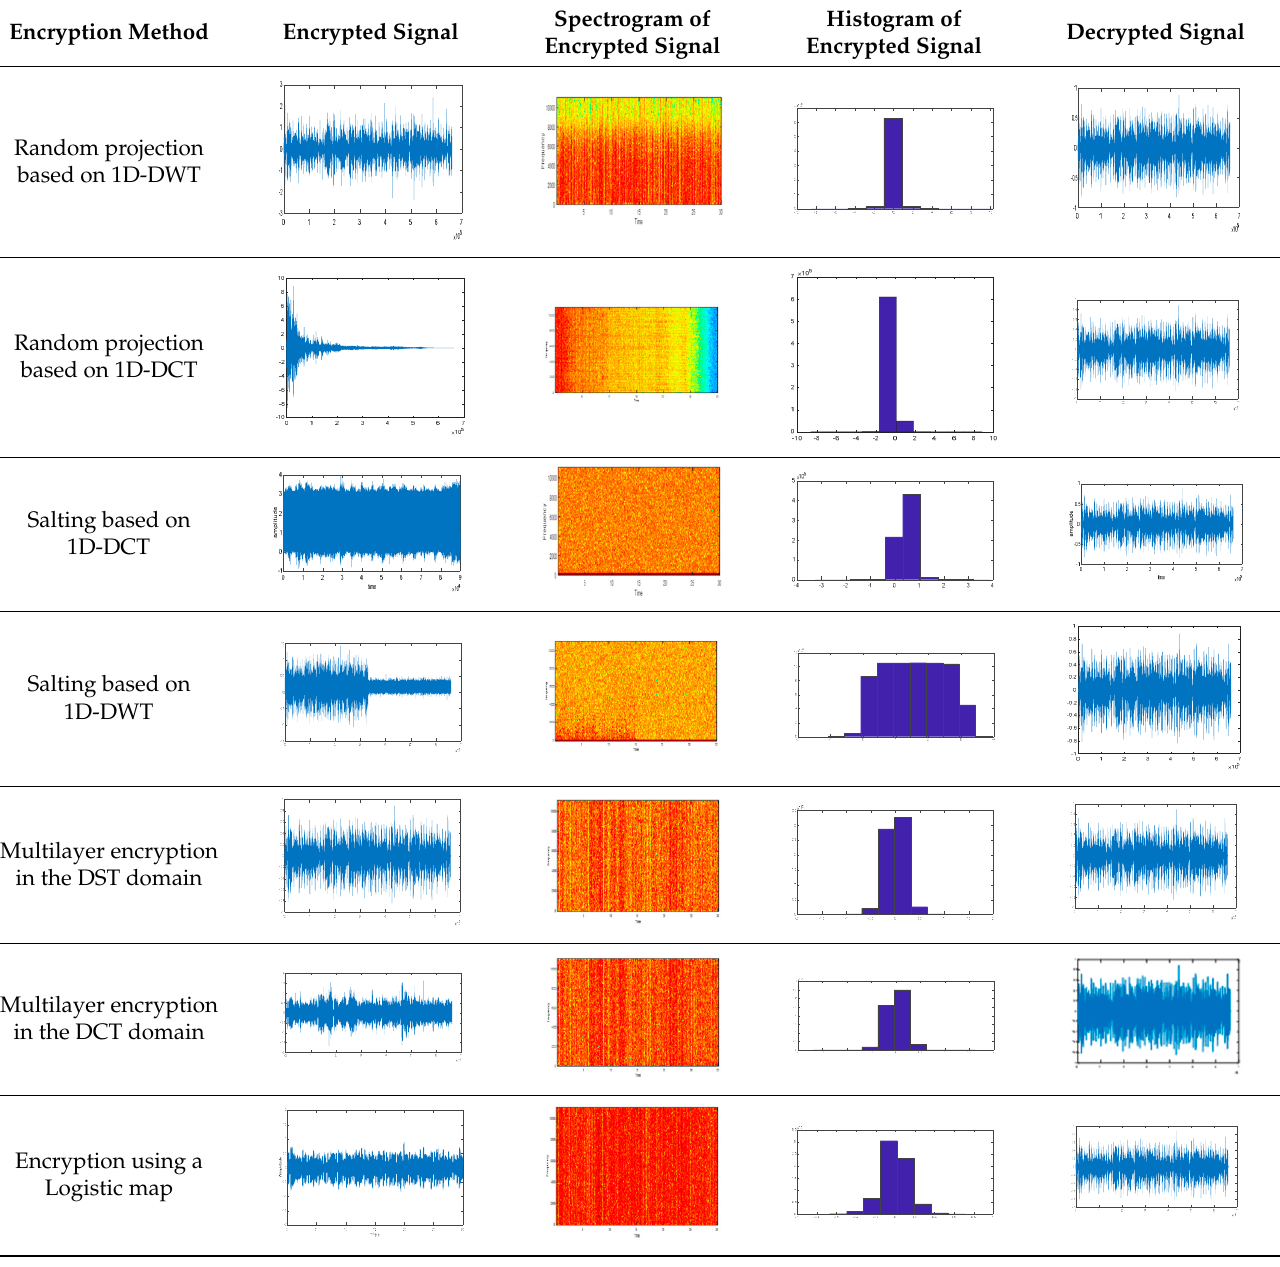
Table 1. Comparison between the results of different encryption schemes.